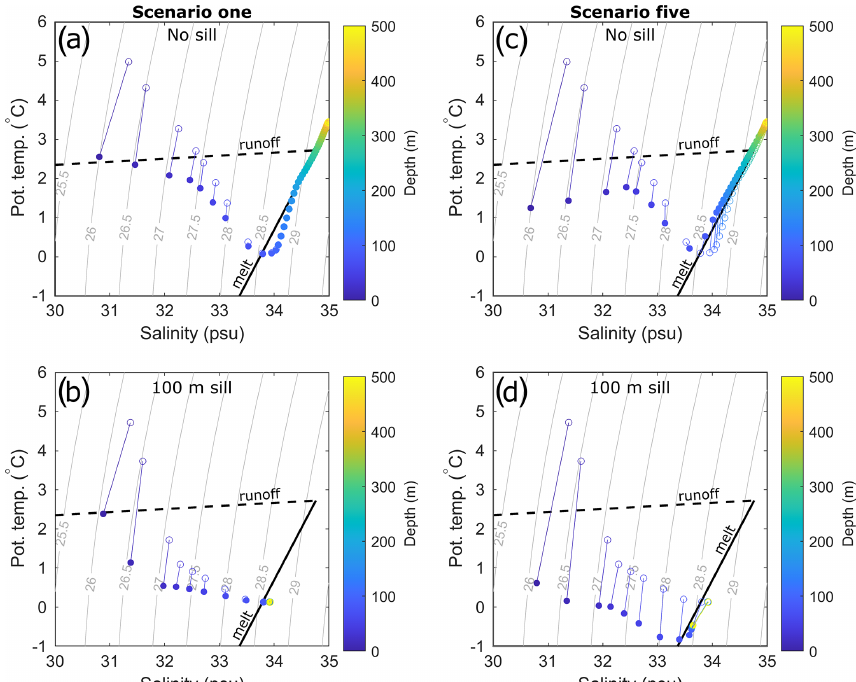
Figure 5. Glacier-adjacent temperature and salinity with (solid circles) and without icebergs (open circles) for various iceberg and sill scenarios and with BCstandard boundary conditions. Panels (a) and (b) show iceberg scenario 1 without a 100m sill (a) and with a sill (b) . Panels (c) and (d) show iceberg scenario 5 without a sill (c) and with a 100m sill (d) . Solid lines joining open and closed circles indicate connected data points extracted from the same model